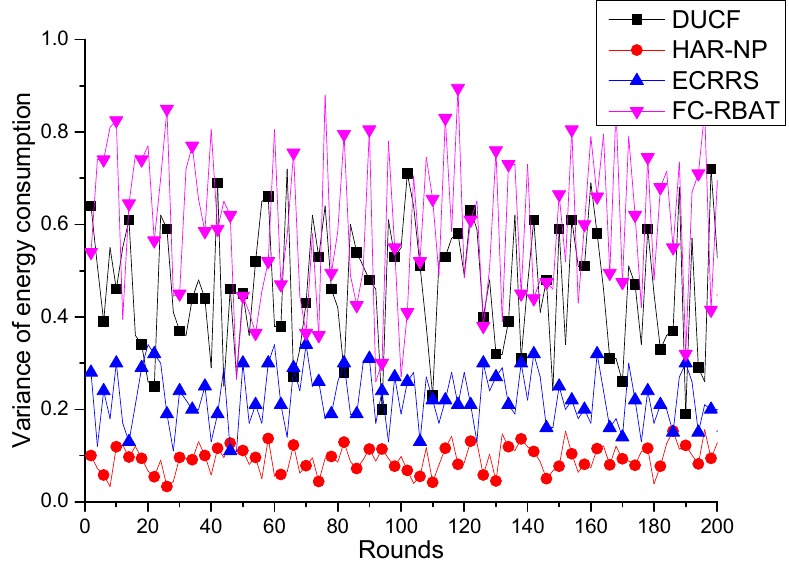
Figure 7. Comparison of the energy consumption variance of network